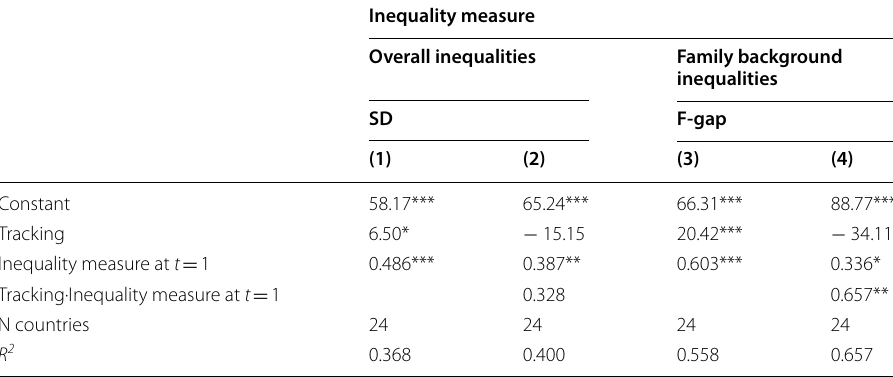
Under the heading SD we report results relative to the effects of tracking on the country standard deviation. Under the heading F‑gap we report results relative to the effects of tracking on the difference between tertiary educated parents with the largest number of books and no tertiary educated parents with the lowest number of books: F‑gap c 1 , where c 1 and c 2 are the coefficients of the family background variables: ln(books) and tertiary education × Columns (1) and (3) refer to the model with no interaction; columns (2) and (4) to models with interaction between the tracking indicator and inequality at t